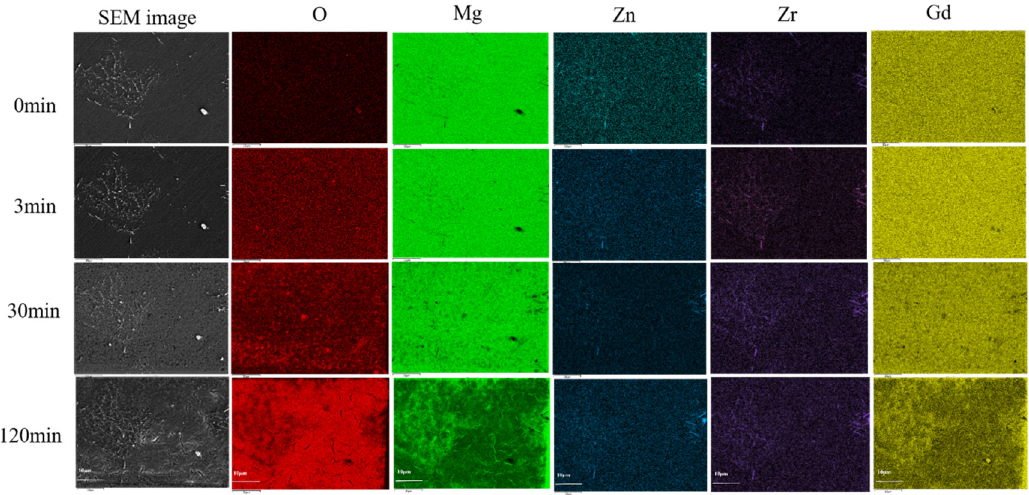
Figure 8. SEM images and element distribution maps of GZ61K alloy following various immersion durations.